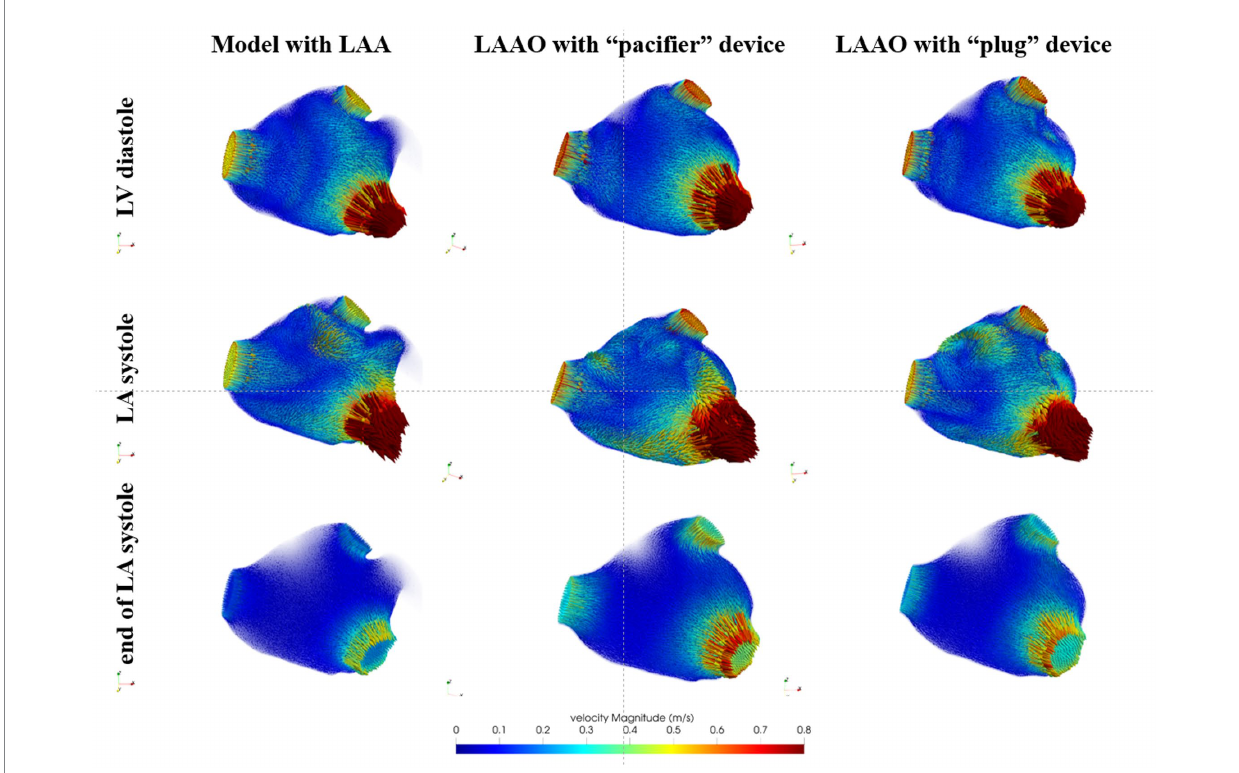
FIGURE 3 Blood flow velocity in the LA models acquired in a representative patient: in the first column we show the model with the left atrial appendage (LAA), in the second column the model after the occlusion with the device based on the pacifier principle and, in the third column, the model after the occlusion with the device based on the plug principle. First row refers to the beginning of ventricular diastole, second row to the atrial systole and the third row to the end of atrial